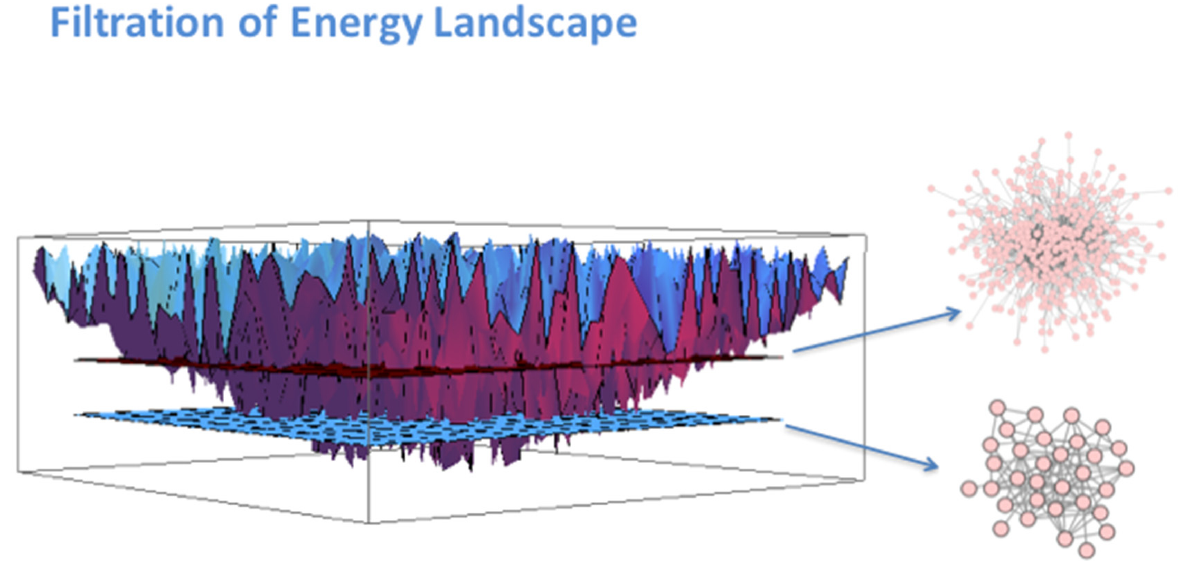
Figure 1. As the “filtration plane” moves up from the bottom, more-and-more nodes are captured in larger-and-larger energetic subnetworks shown on the right-hand side of the figure.